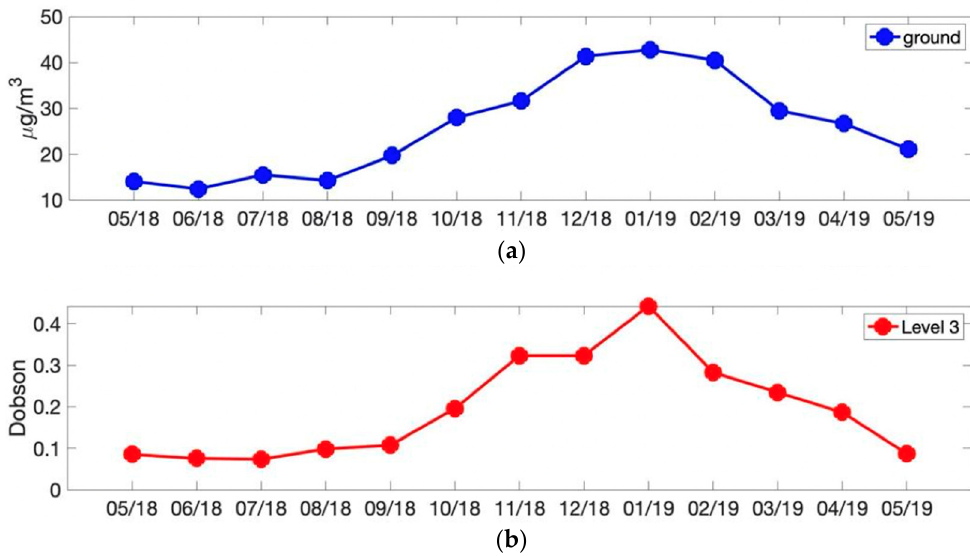
Figure 8. Ground ( a ) and Level 3 ( b ) NO 2 monthly time series for the Bologna-De Amicis station. The analysis refers to the period of May 2018 – May 2019.